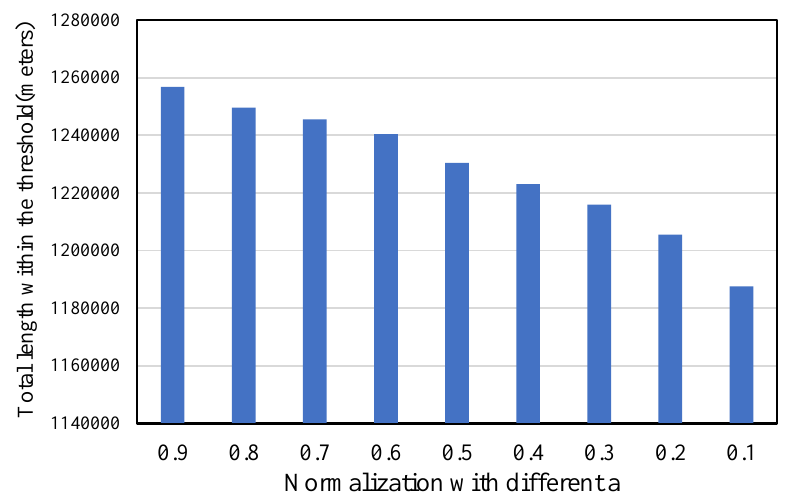
Figure 7. The 5-min coverage length of service areas of fire stations in our result by using different weights ( 𝑎 ) for geometric distance and fire risk.